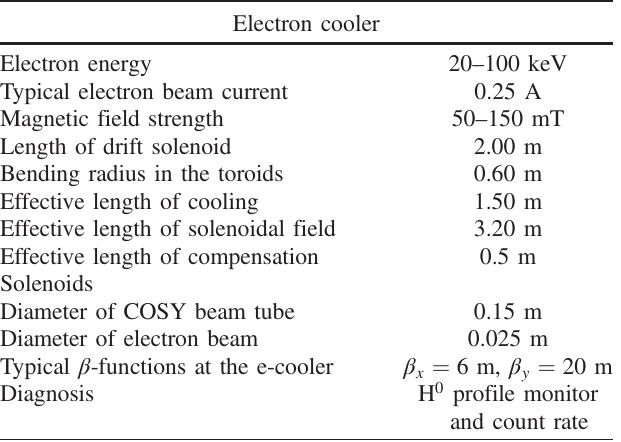
TABLE II. Parameters of the electron cooler at COSY [42].